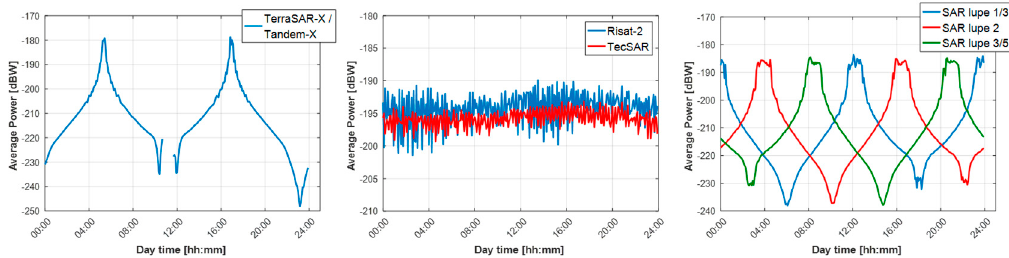
Figure 6. Estimation of the radio frequency interferences (RFI) power, as a function of the hour of the day, for three different cases: a SS/DD satellite with near polar orbit ( left ), two satellites with low inclined orbit ( center ), and a set of five satellites with SS orbits in three different planes ( right ).